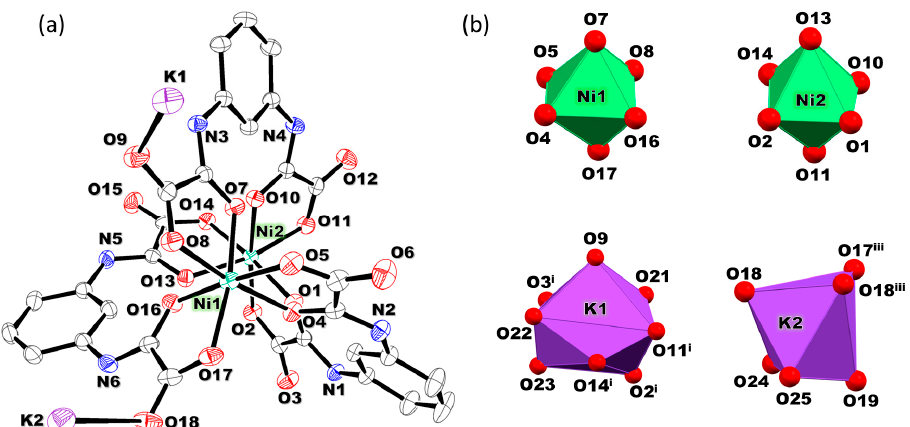
Figure 2. Views of the structure of 1 : ( a ) representation of a fragment of the crystal structure displaying ellipsoids at the 30% probability level (hydrogen atoms and solvent molecules of crystallization were omitted for clarity); ( b ) coordination polyhedra around the Ni II and K I metal centers. [Symmetry code: (i) = − x + 3/2, y − 1/2, − z + 1/2 ; (ii) = x − 1/2, − y + 1/2, z + 1/2 ; (iii) = − x + 2, − y, − z ].